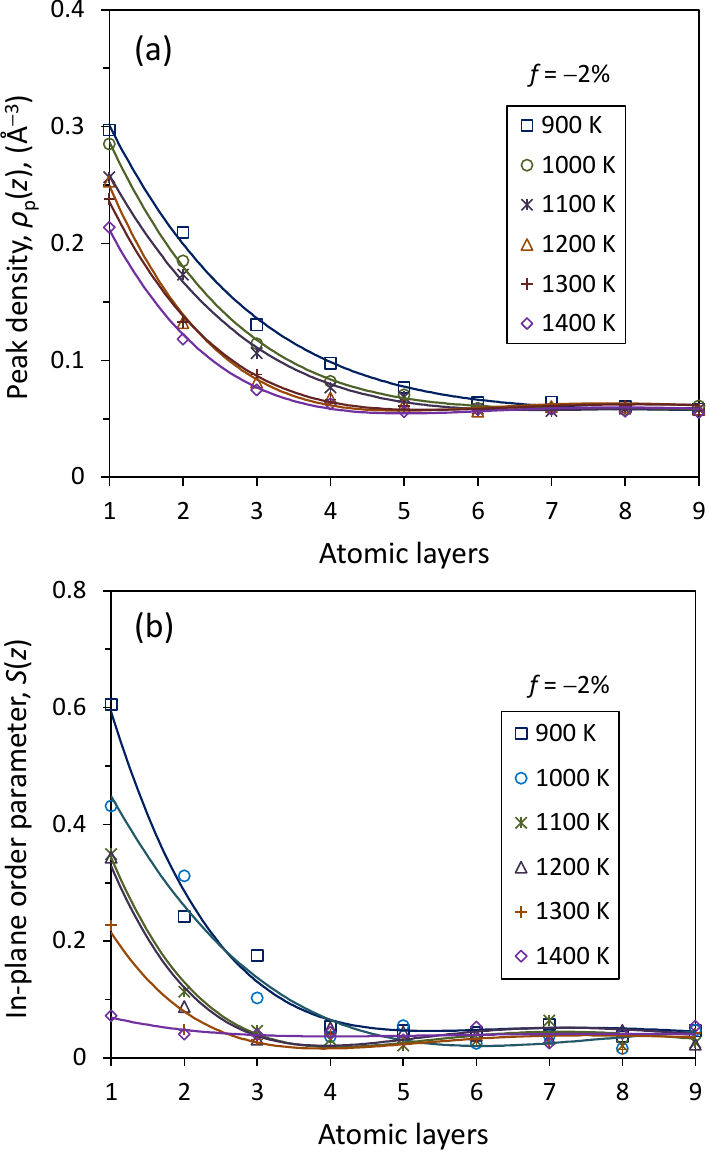
Figure 3. Temperature effect on prenucleation [18]. ( a ) Peak density, ρ P ( z ), of the density profile and ( b ) in-plane atomic order parameter, S ( z ), as functions of temperature, T , and atomic layers away from the interface for the system with − 2% misfit. The scattered data and solid lines represent the calculated values of ρ P ( z ) or S ( z ) and the fitted lines, respectively. Both the atomic layering and in-plane atomic ordering decrease with increasing T . However, at T = 1400 K, the in-plane atomic ordering almost vanishes, while the atomic layering persists within approximately four atomic layers. (Reprinted with permission from Ref. [18]. Copyright 2022, Spring Nature.)